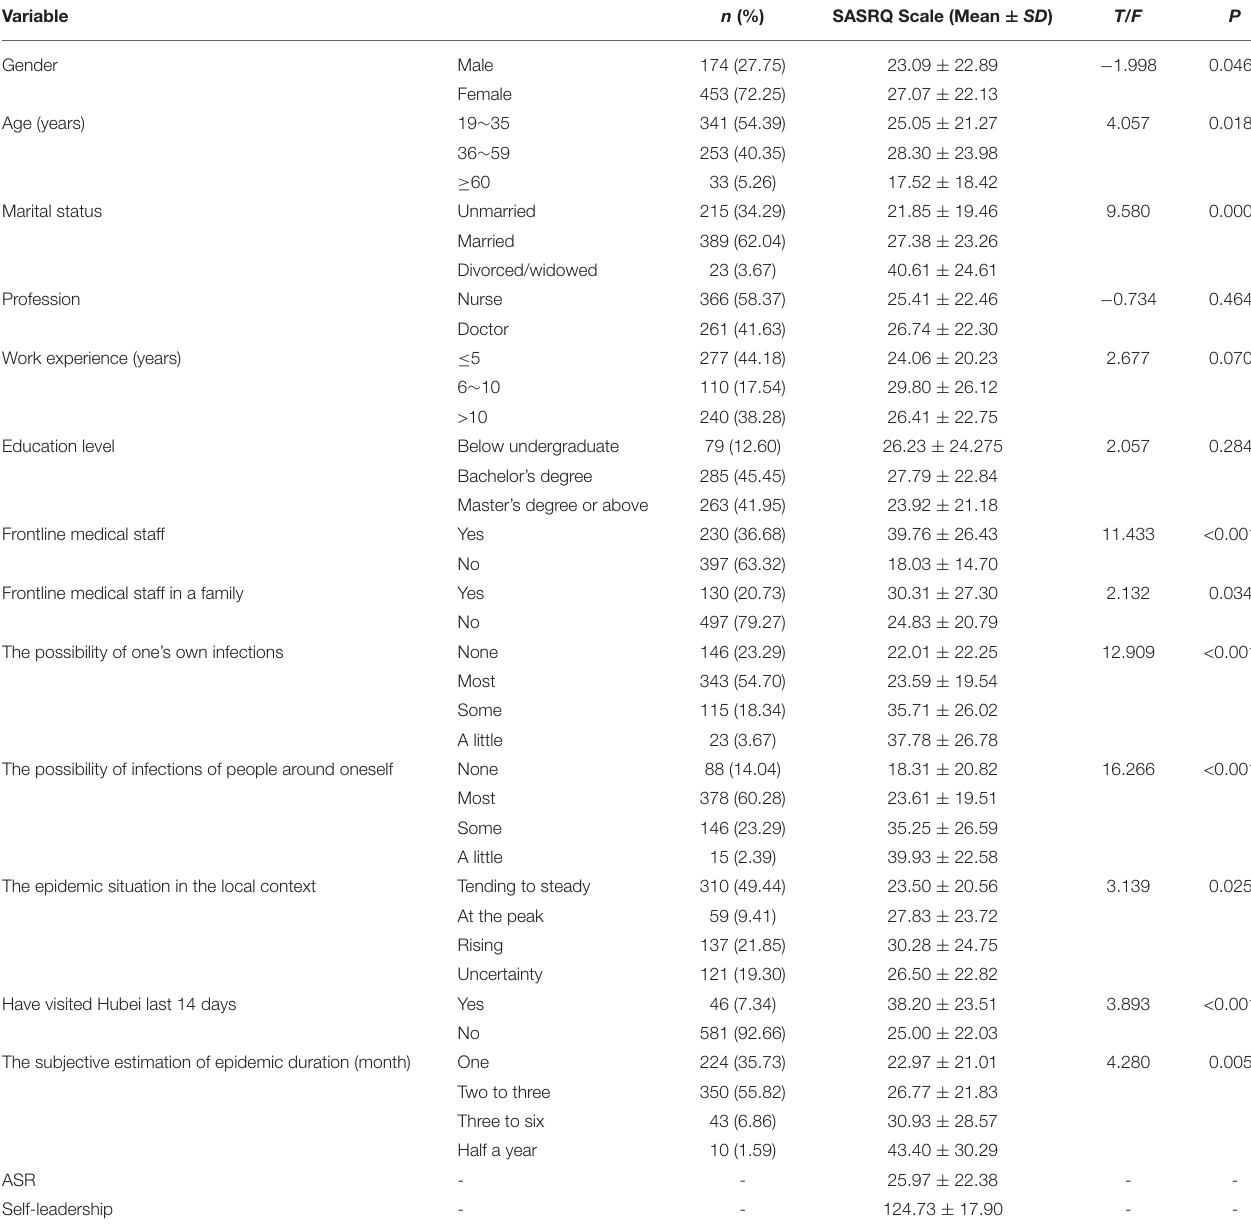
TABLE 1 | The univariate analysis of the medical staff’s ASR due to COVID − 19 ( n = 627).